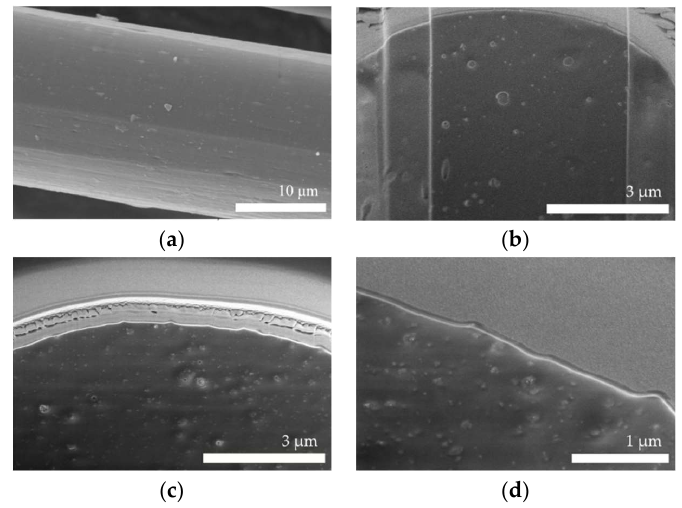
Figure 2. SEM images of cellulose fibers: ( a ) 3% of silver nanoparticles (AgNPs); cross section of: ( b ) undoped fibers ( c , d ) fibers containing 3% of AgNPs.